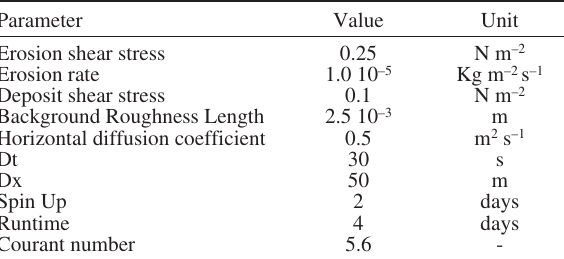
Table 1. – Parameters used in the modelling of Villa del Mar and Puerto Cuatreros. Parameter Value Unit Erosion shear